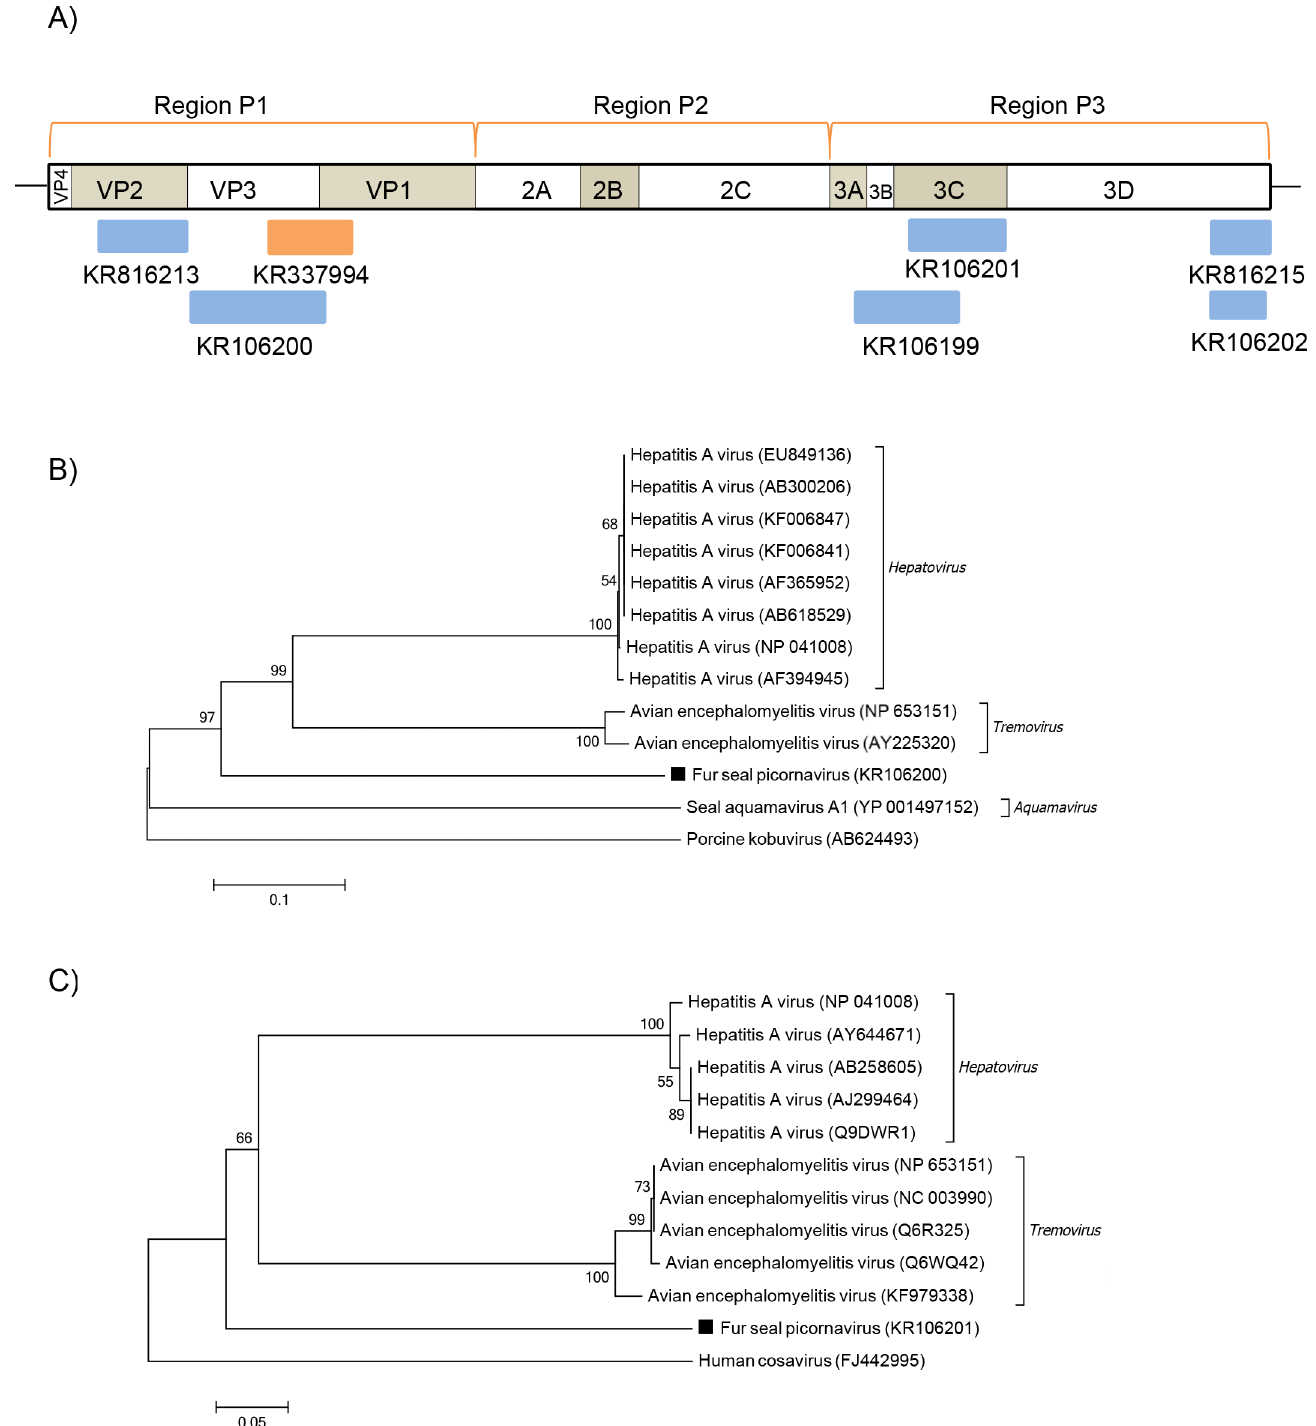
Fig 5. Phylogenetic analysis of fur seal picornavirus. (A) Schematic representation of the genome of picornaviruses using as an example the hepatits A virus (~7.4 kb). The blue bars represent the contigs from South American fur seal and the orange bars represent the contigs from Subantarctic fur seal. (B) Neighbor-joining phylogenetic tree based on the alignment of partial amino acid sequences (219 aa) from the P1 region of the polyprotein of 13 picornaviruses. Porcine kobuvirus was used as outgroup. (C) Neighbor-joining phylogenetic tree based on the alignment of partial amino acid sequences (122 aa) from the P3 region of the polyprotein of 12 picornaviruses. Human cosavirus was used as outgroup. The picornavirus sequences from South American fur seal identified in this study are labeled with a black square. The GenBank accession numbers of the viral sequences are shown in parentheses.